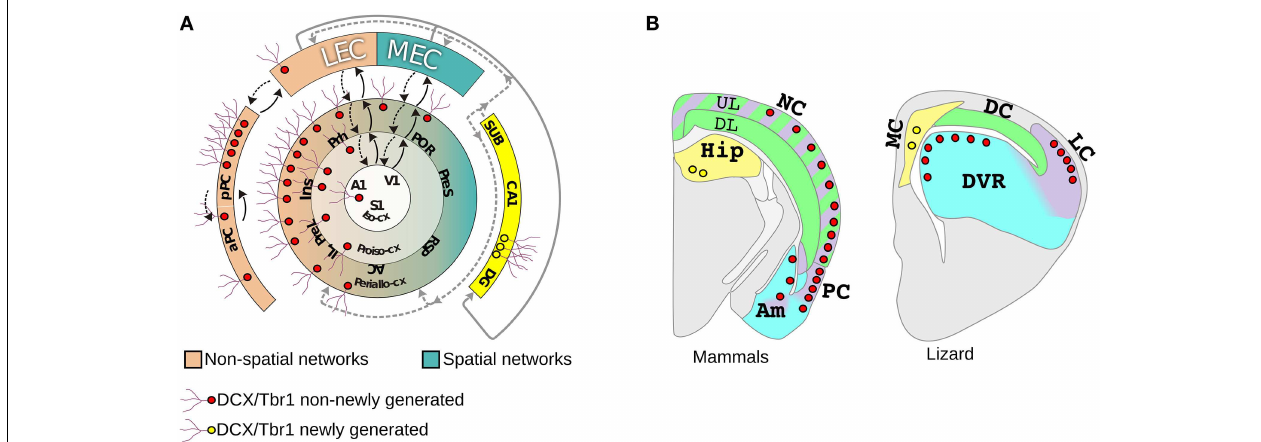
turquoise green respectively, feedforward (solid arrows) and feedback (dashed arrow) pathways are also shown. (B) Schematic coronal sections showing the distribution of DCX + /Tbr1 + cells in different pallial domains in mammals (left) and lizard (right). Additional abbreviations: A1, primary auditory cortex; AC, anterior cingulate cortex; DP, dorsal pallium; IL, infralimbic cortex; Ins, insular cortex; pPC posterior piriform cortex; aPC; anterior piriform cortex; PreL, prelimbic cortex; PreS, presubiculum; POR, postrhinal cortex; Prh, perirhinal cortex; RSP, retrosplenial cortex; SUB, subiculum. Redrawn from Luzzati et al.